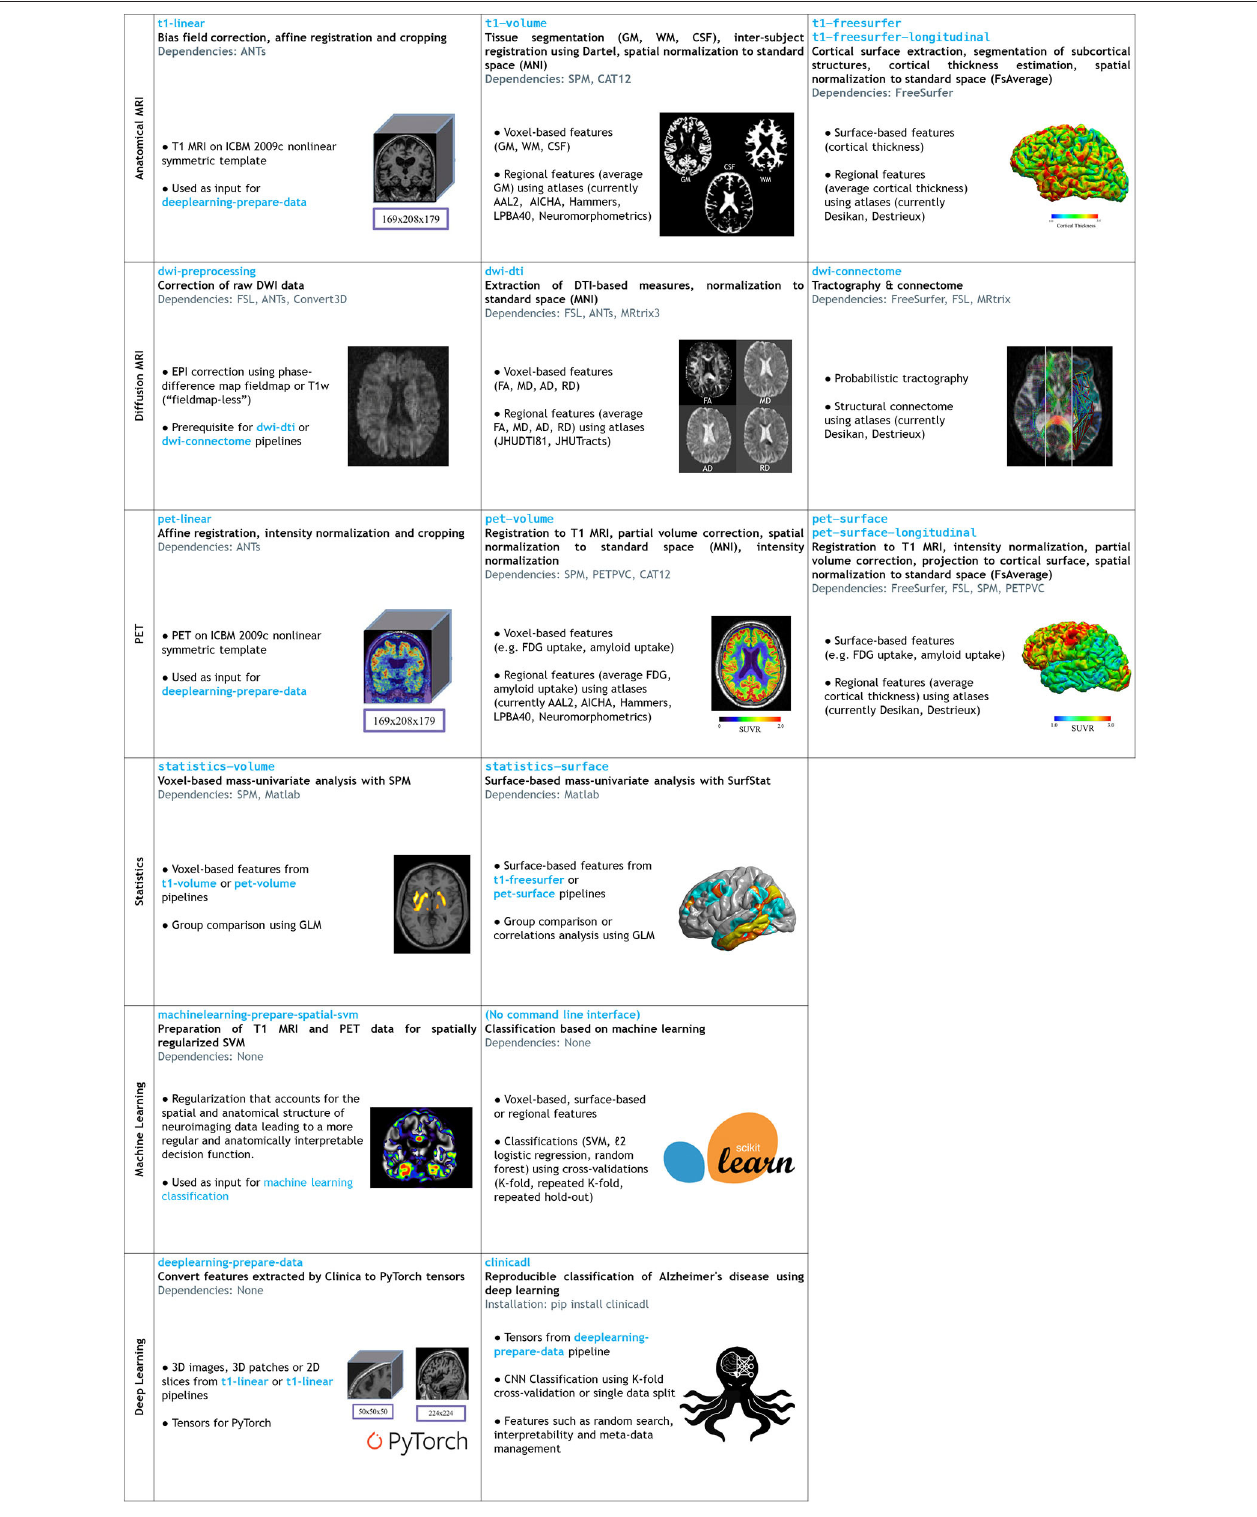
FIGURE 2 | List of the pipelines currently available in Clinica with their dependencies and outputs. Explanations regarding the atlases can be found in section List of Atlases Available in Clinica. GM, gray matter; CSF, cerebrospinal fluid; WM, white matter; FA, fractional anisotropy; MD, mean diffusivity; AD, axial diffusivity; RD, radial diffusivity, SVM, Support Vector Machine; ICBM, International Consortium for Brain Mapping.